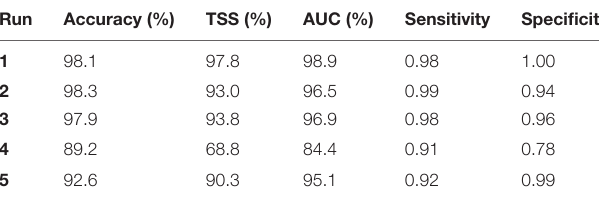
TABLE 3 | Performance metrics of the validation dataset for each random forest